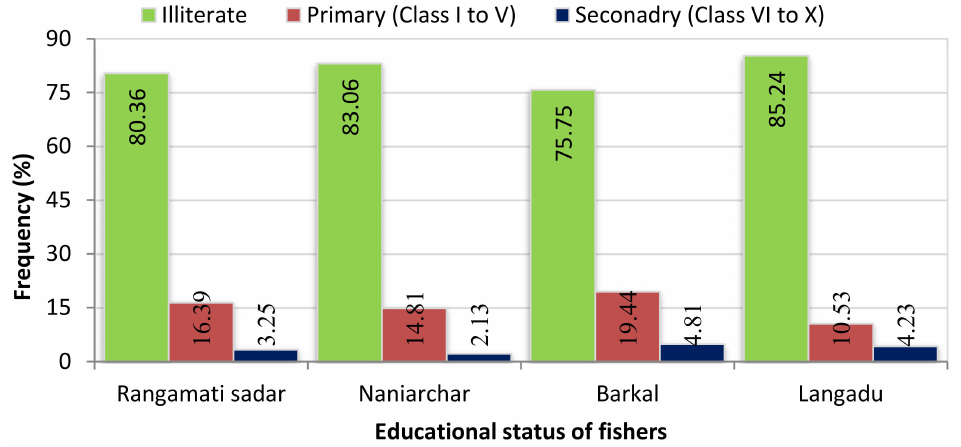
Figure 2. Educational status among the studied fishermen in the four study sites of Kaptai lake.